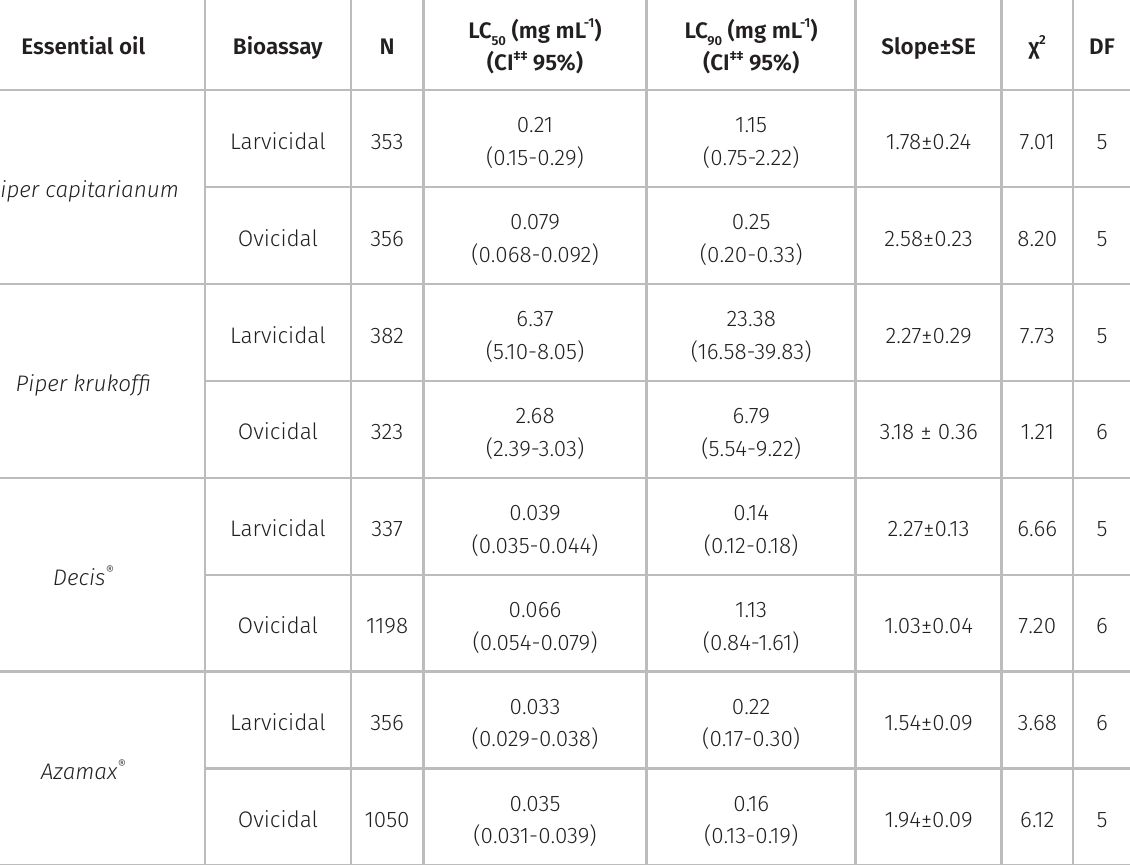
Table II. Toxicity of the Piper essential oil against Plutellla xylostella.